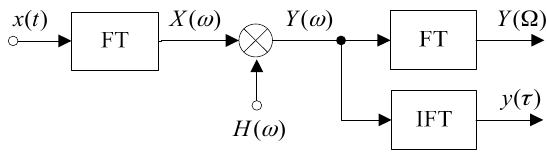
Figure 1. Block diagram of a frequency-domain matched filter (MF).